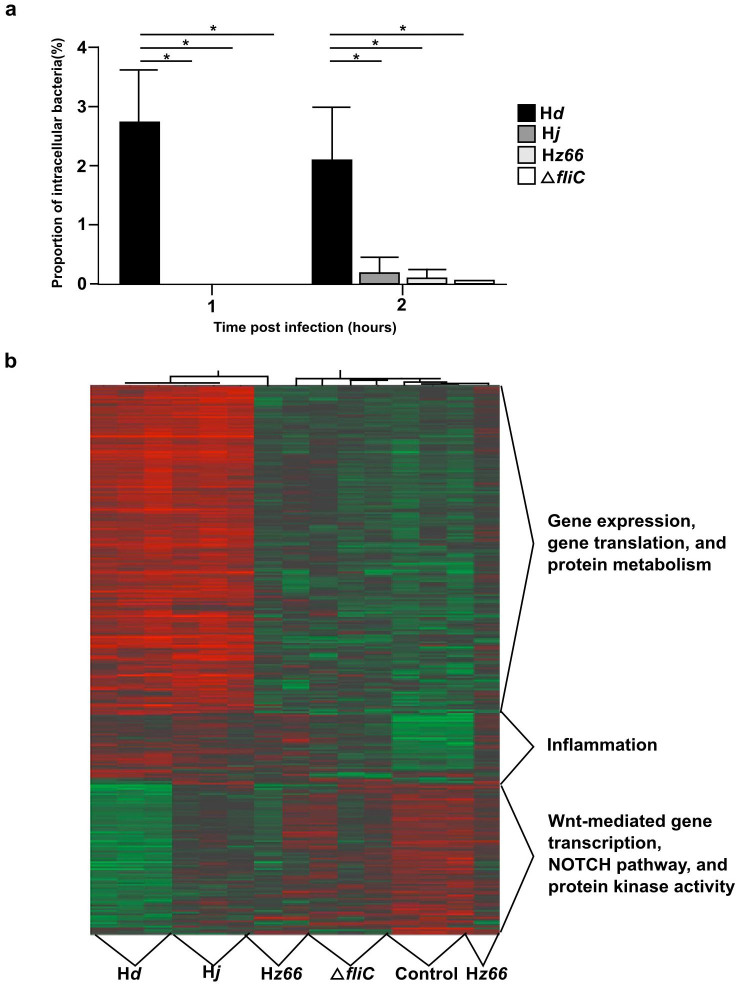
The interaction of S. Typhi flagella derivatives with macrophages.The moncytic THP-1 cell line was differentiated into macrophages and infected with S. Typhi expressing one of the three-flagellin variants and the non-flagellated mutant (ΔfliC) (a) Histogram showing the median proportion of recovered (intracellular) bacteria normalized by the inoculum and averaged over six experiments at 1 and 2 hours post infection. Asterisk highlights statistically significant variations by pairwise comparison (p<0.001), error bars represent one standard deviation. (b) THP-1 cells were infected and RNA was isolated for microarray analysis of host mRNA population. Figure shows hierarchical clustering of differentially expressed genes in THP-1 cells infected with the three flagellin derivatives, and the non-flagellated mutant (ΔfliC), compared with uninfected THP-1 cells. The cut-off for differentially expressed genes was an absolute fold change >2 and FDR corrected p-value of <0.05. Red/green color scale indicates level of gene expression, red indicates increased gene expression, and green indicates reduced gene expression.